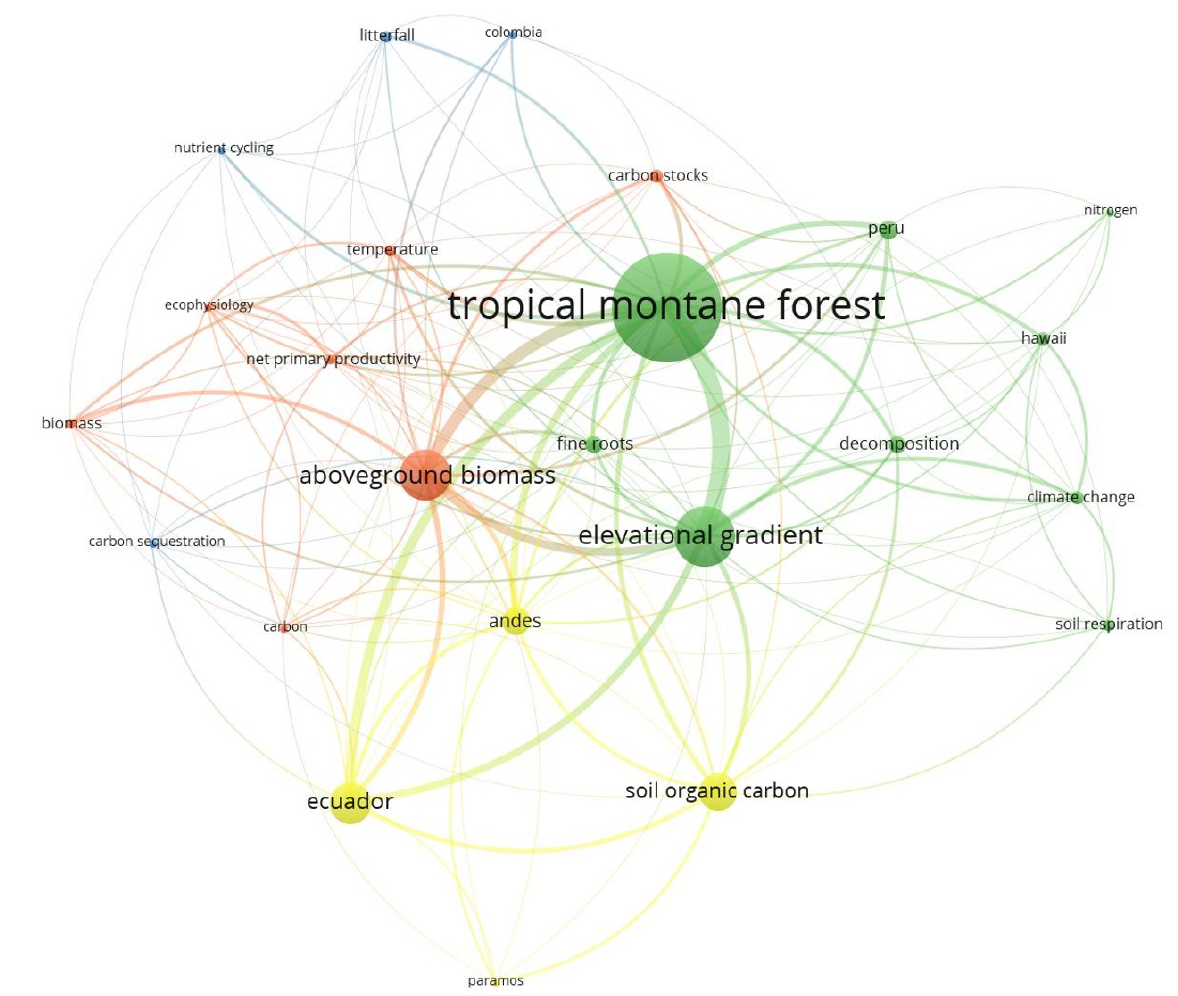
Figure 1. Analysis of the co-occurrence of keywords in publications of the carbon cycle in tropical upland ecosystems. Each colour corre- sponds to a different cluster. The size of each node shows the frequency of occurrence. The distance between two nodes indicates the number of co-occurrence of the two keywords; that is, the larger the distance between two nodes, the lower the co-occurrences of the two keywords. The co-occurrence in the same publication is represented by the curves between the